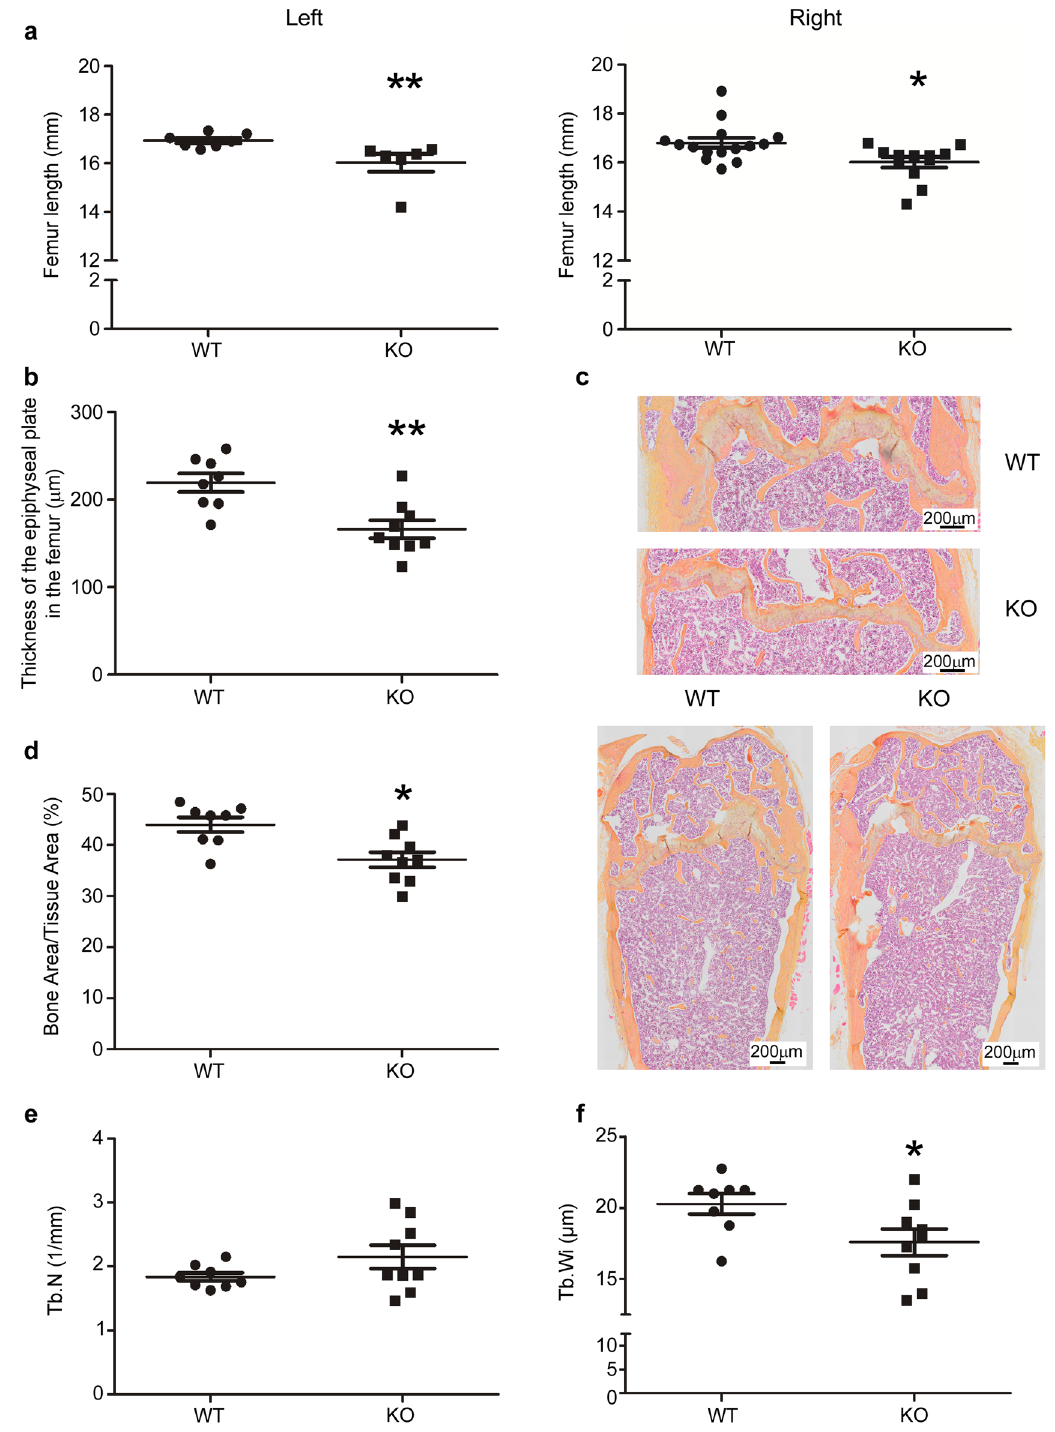
Figure 4. Femur length, thickness of the epiphyseal plate, percentage of bone matrix, and trabecular width in Hyal1 −/− (KO) mice are decreased compared to WT mice. ( a ) Left (n ≥ 6) and right (n ≥ 12) femurs were isolated from 1-year-old mice. Their length (in mm) was measured with a digital caliper. ( b , c ) The thickness of the epiphyseal plate at the distal extremity of femurs from 18-month-old mice was quantified on 7 histological sections from each mouse (representative slides shown in c ). Eight measures were taken across the epiphyseal plate and averaged for each section (n ≥ 8 mice per group). ( c , d ) From the same histological slices, we calculated the percentage of bone area (light orange after hematoxylin eosin saffron coloration) compared to the total tissue area (n ≥ 8 mice in each group, 7 sections for each mouse). ( e , f ) Analyses of Trabecular Number (Tb.N) ( e ) and Trabecular Width (Tb.Wi) ( f ) in epiphyses (4 bone slices per mice, n ≥ 8 mice per group). The graphs represent the means ± SEM. *p < 0.05, **p < 0.01 (two-tailed Mann–Whitney U